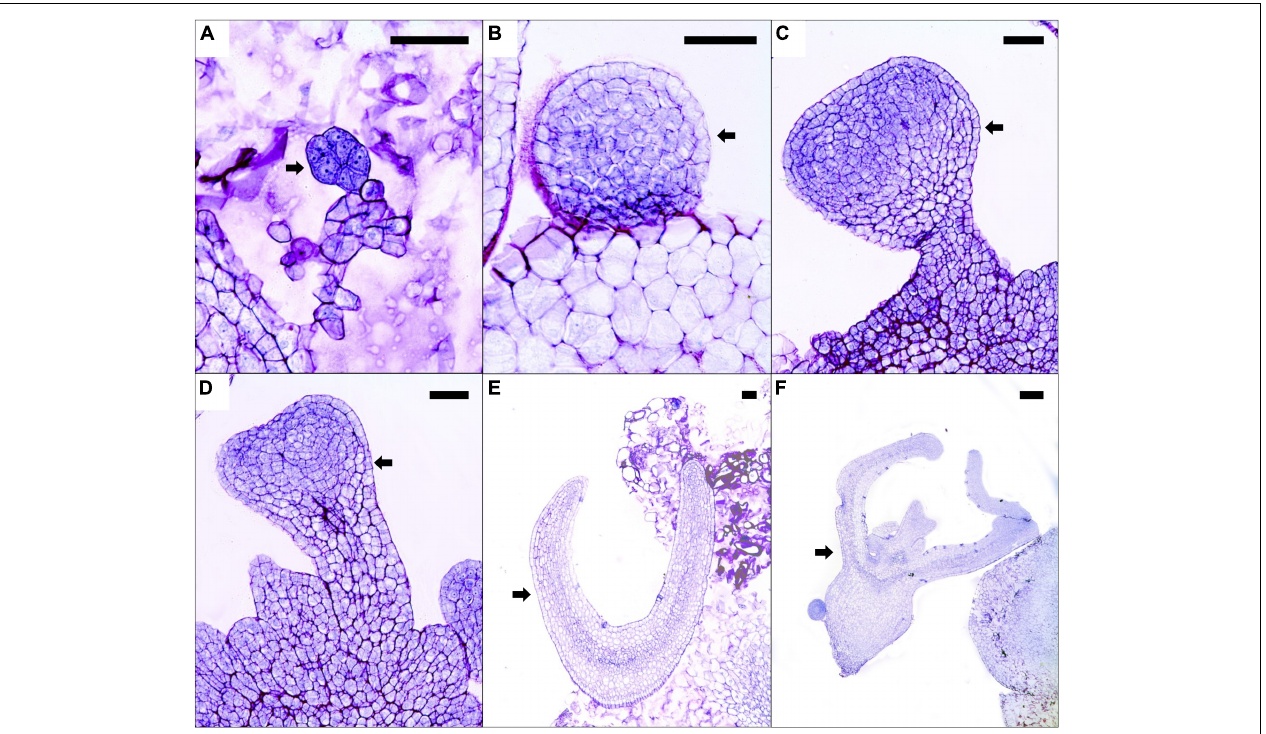
FIGURE 2 | Histological sections of calluses with embryogenic structures cultured on medium supplemented with 9.0 µ M 2,4-D after 8 months of culture. Arrows indicate a pro-embryo (A) , globular (B) , early-heart shaped (C) , heart-shaped (D) , torpedo-like (E) , and cotyledonary somatic embryos (F) . Black bars scale equivalent to 100 µ m (A–E) and 200 µ m (F)